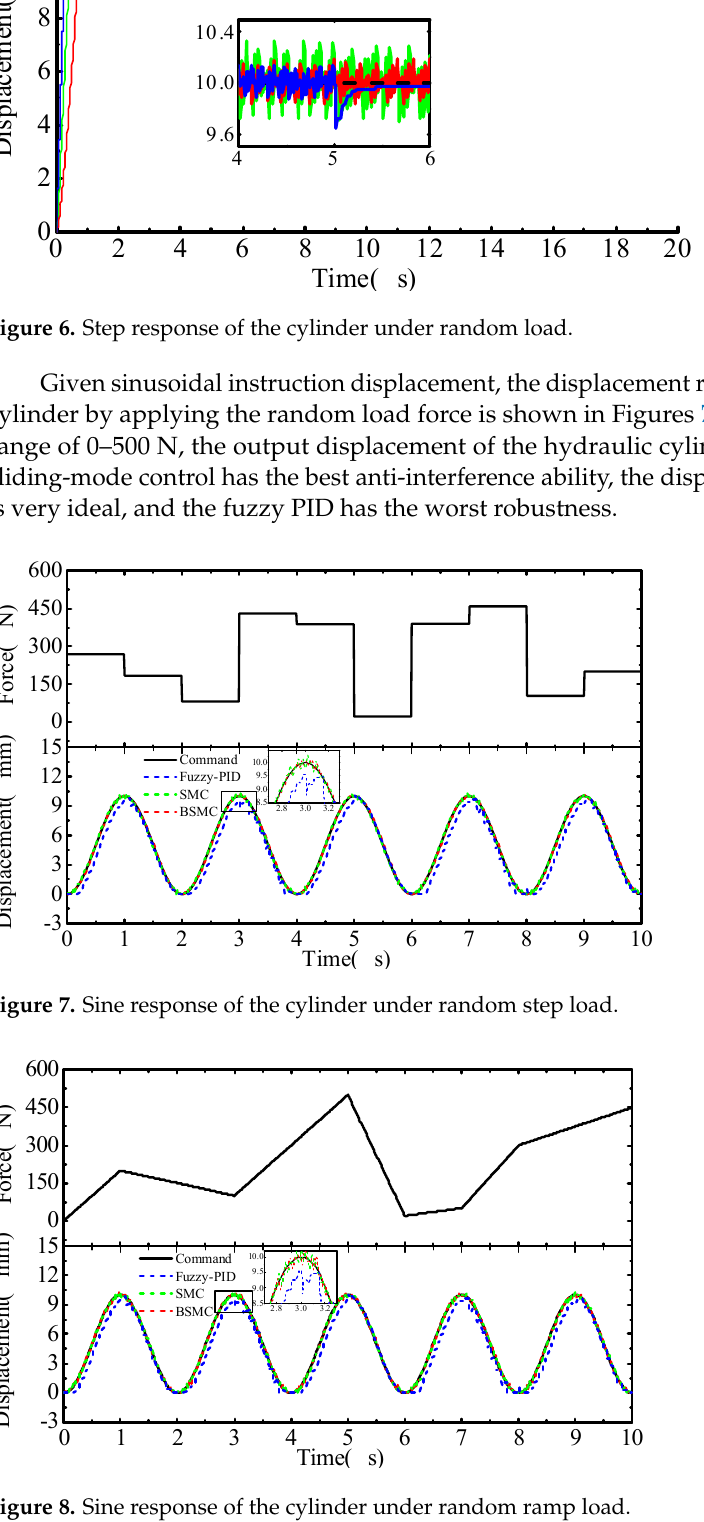
Figure 9. Sine response of the cylinder under random sinusoidal load. 0 Time( s) Figure 10. Tracking error of sinusoidal response of the cylinder under random load. Figure 11 shows the velocity change of the hydraulic cylinder under sinusoidal in- structions with a random load. It can be seen that the fluctuation range of the cylinder speed with conventional sliding-mode control is smaller than that with fuzzy-PID, alt- hough both are larger than that with backstepping sliding-mode control. The cylinder speed with the three control algorithms is illustrated in Figure 11. The system adopting the fuzzy PID has the largest fluctuation amplitude of the tracking error, Comparatively, the backstepping sliding-mode control allows the system with the lowest fluctuation ampli- tude of the tracking error.